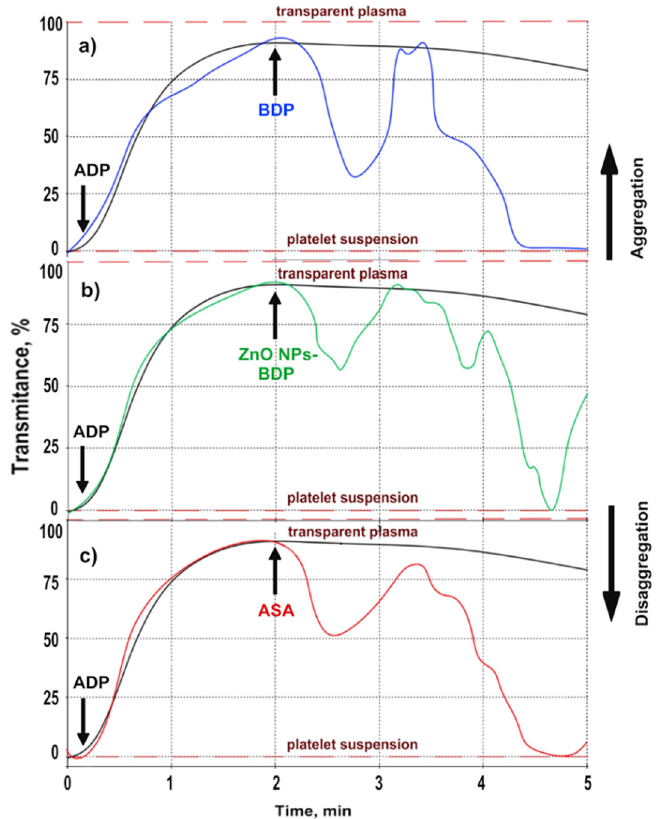
Figure 2. The inhibition of platelet aggregation (blood of volunteers), induced by ADP (3.75 µ M), under the influence of 6.65 mM of BDP ( a ), ZnO NPs-BDP 6.65 mM ( b ), and ASA 1.40 mM ( c ). The black line is the control, which means ADP action only (3.75 μ M). Table 2. The inhibition (%) of platelet aggregation by 6.65 mM of BDP, ZnO NPs-BDP 6.65 mM, and ASA 1.40 mM.